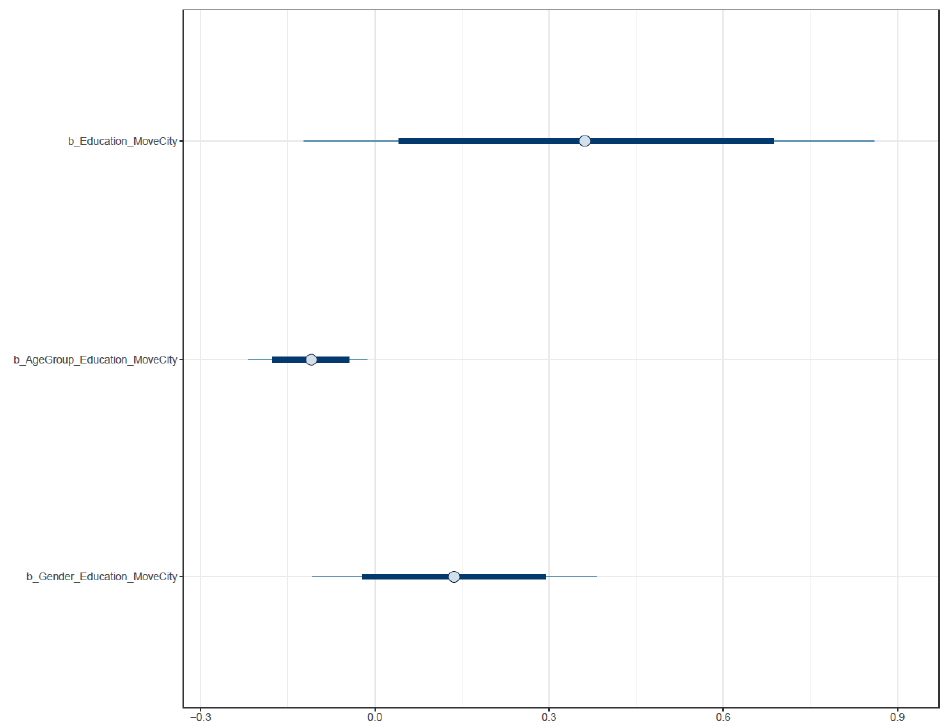
Figure 6. Distribution of Model 1′s posterior coefficients estimated with uninformative priors.